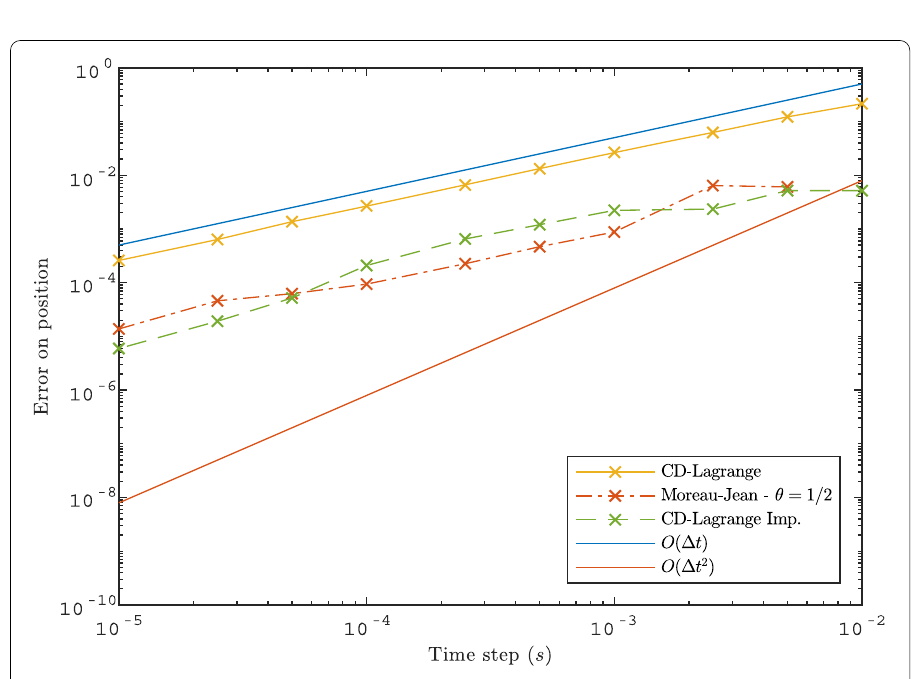
Fig. 13 Van der Pol oscillator—convergence order for position with